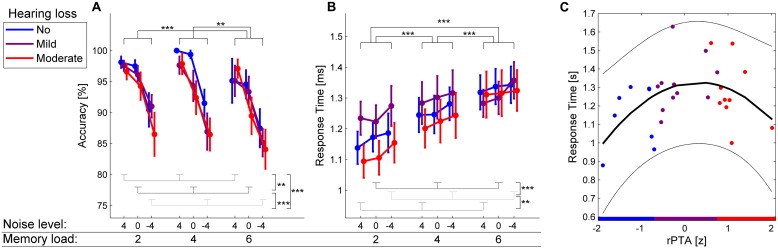
Behavioral results. (A,B) Accuracy and response times in the auditory Sternberg task for participants with no HL (blue), mild HL (purple), and moderate HL (red) as a function of memory load (2, 4, 6 to-be-remembered items) and background noise level (4, 0, –4 dB SRT80). Error bars show ±1SEM. ∗∗p < 0.01, ∗∗∗p < 0.001. (C) Statistically significant quadratic regression between the z-scored rPTA and response times (p = 0.025). The least-squares regression line is shown in black. The 95% confidence interval is shown in thin lines. The slight overlap in rPTA of the three groups of HL is because the three groups were created before the impact of age on HL was regressed out (see Materials and Methods for details). Note that higher rPTA values indicate more severe HL.